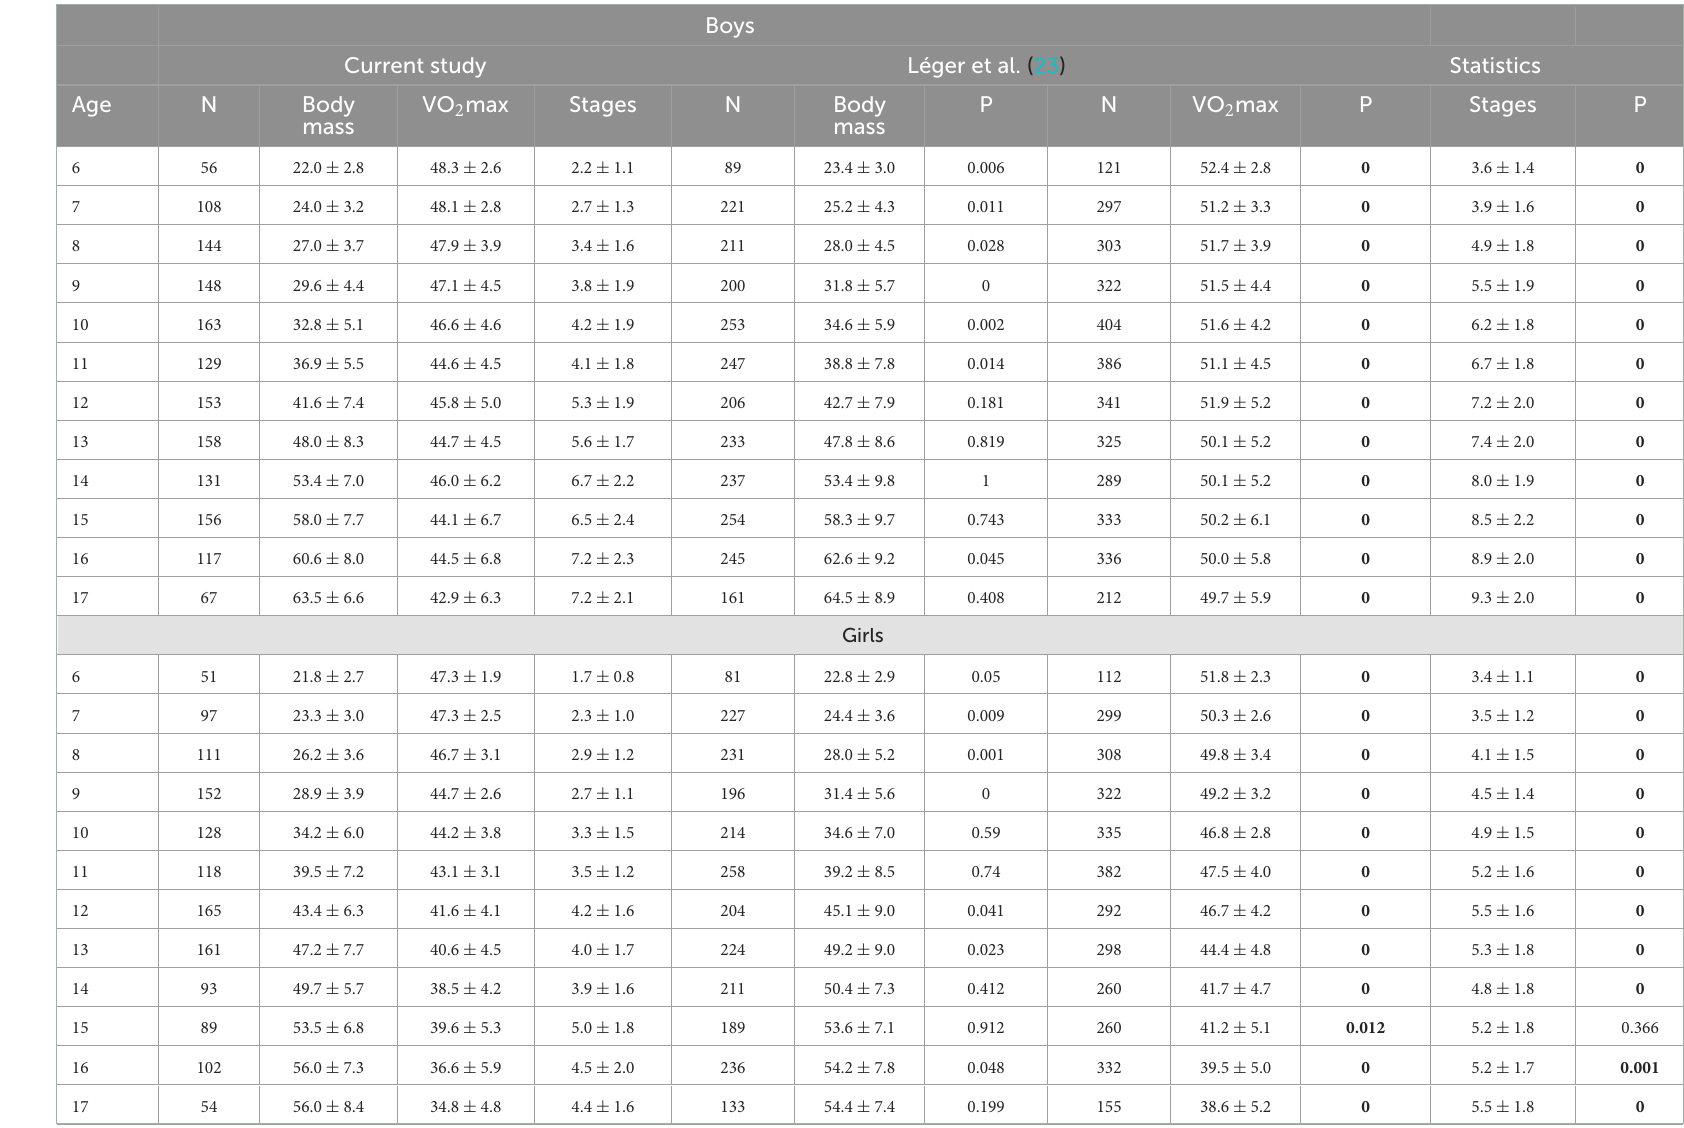
TABLE 6 Comparison of VO2max and the number of stages completed between Current study and Léger et al. (23) with adjustment for